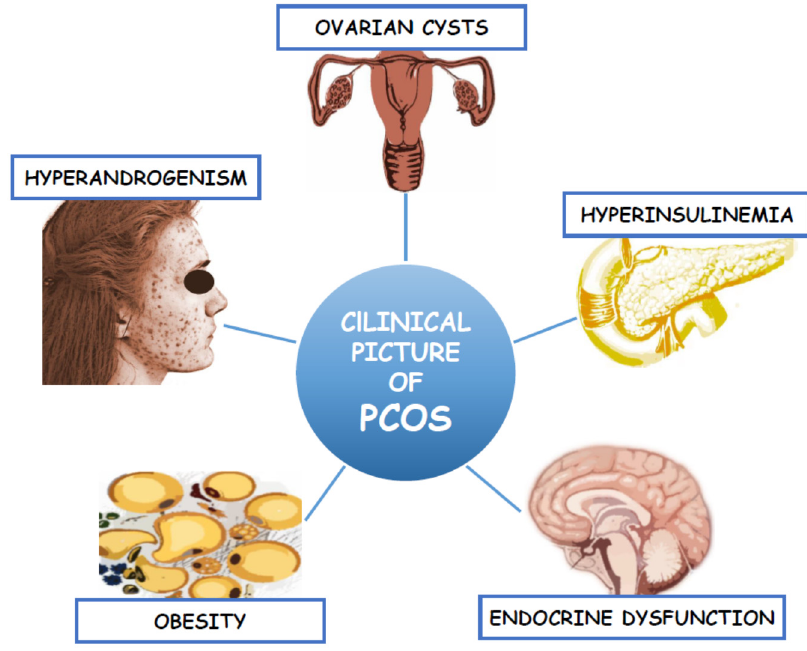
Figure 1. Clinical picture of Polycystic Ovary Syndrome .